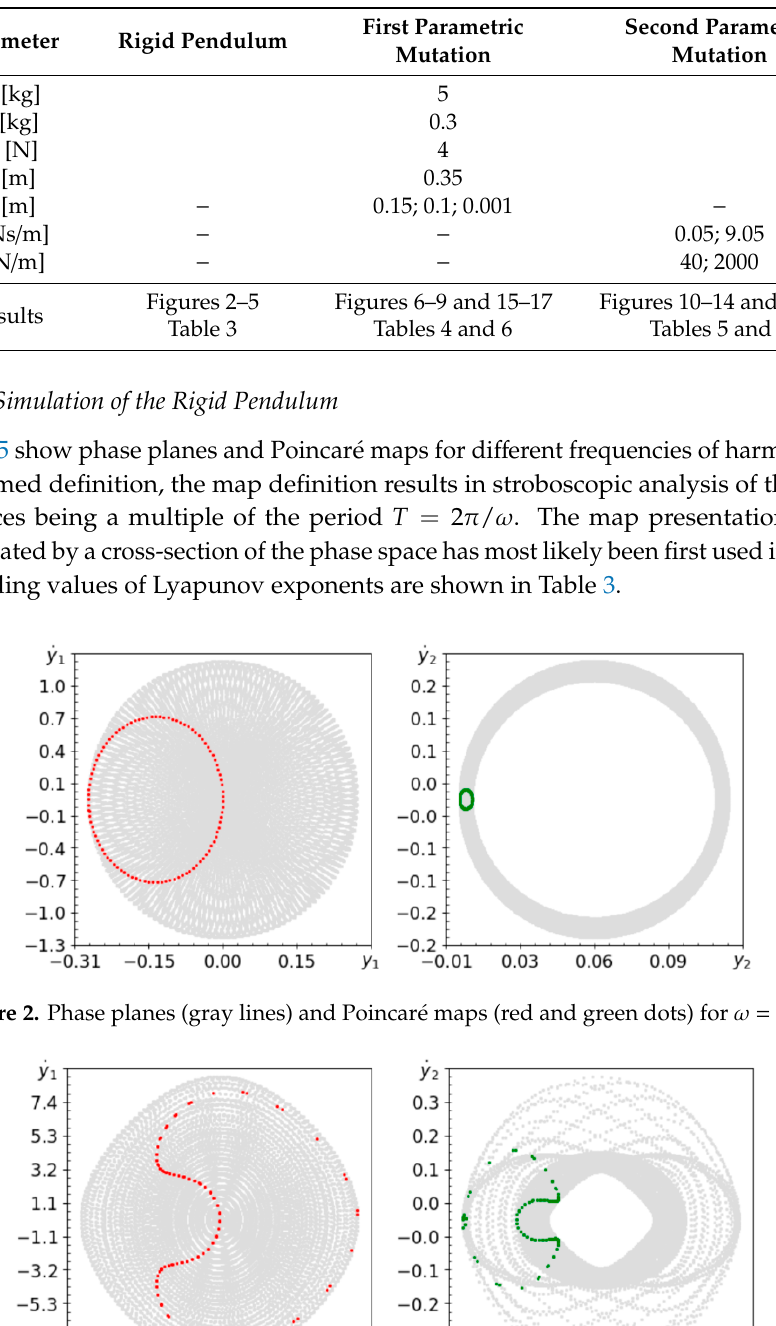
Table 2. Parameters of the simulations (values of M , m , F 0 and l 0 are common for all the systems). Parameter Rigid Pendulum